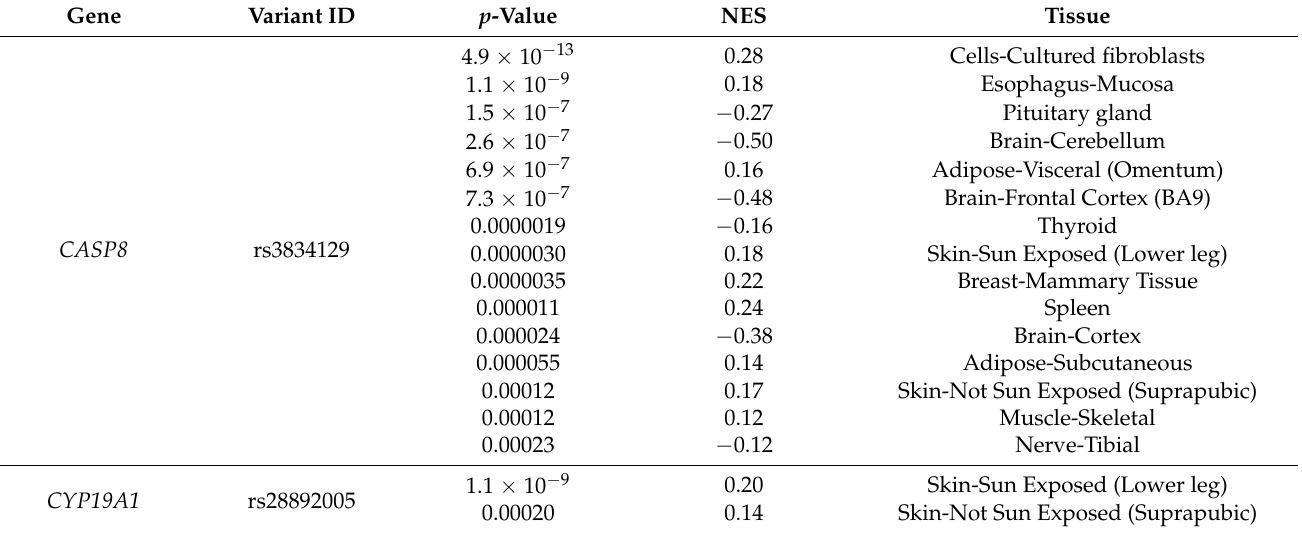
Table 3. Differentially expressed variants in diverse tissues from GTEx. NES, Normalized Effect